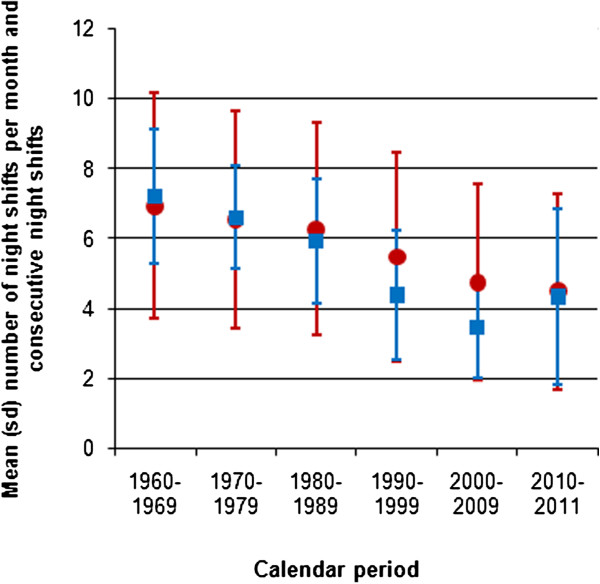
Mean number of night shifts per month and number of consecutive night shifts by calendar period (1960–2011). Legend: red dots indicate the number of nights worked per month; blue squares indicate the number of consecutive nights worked.